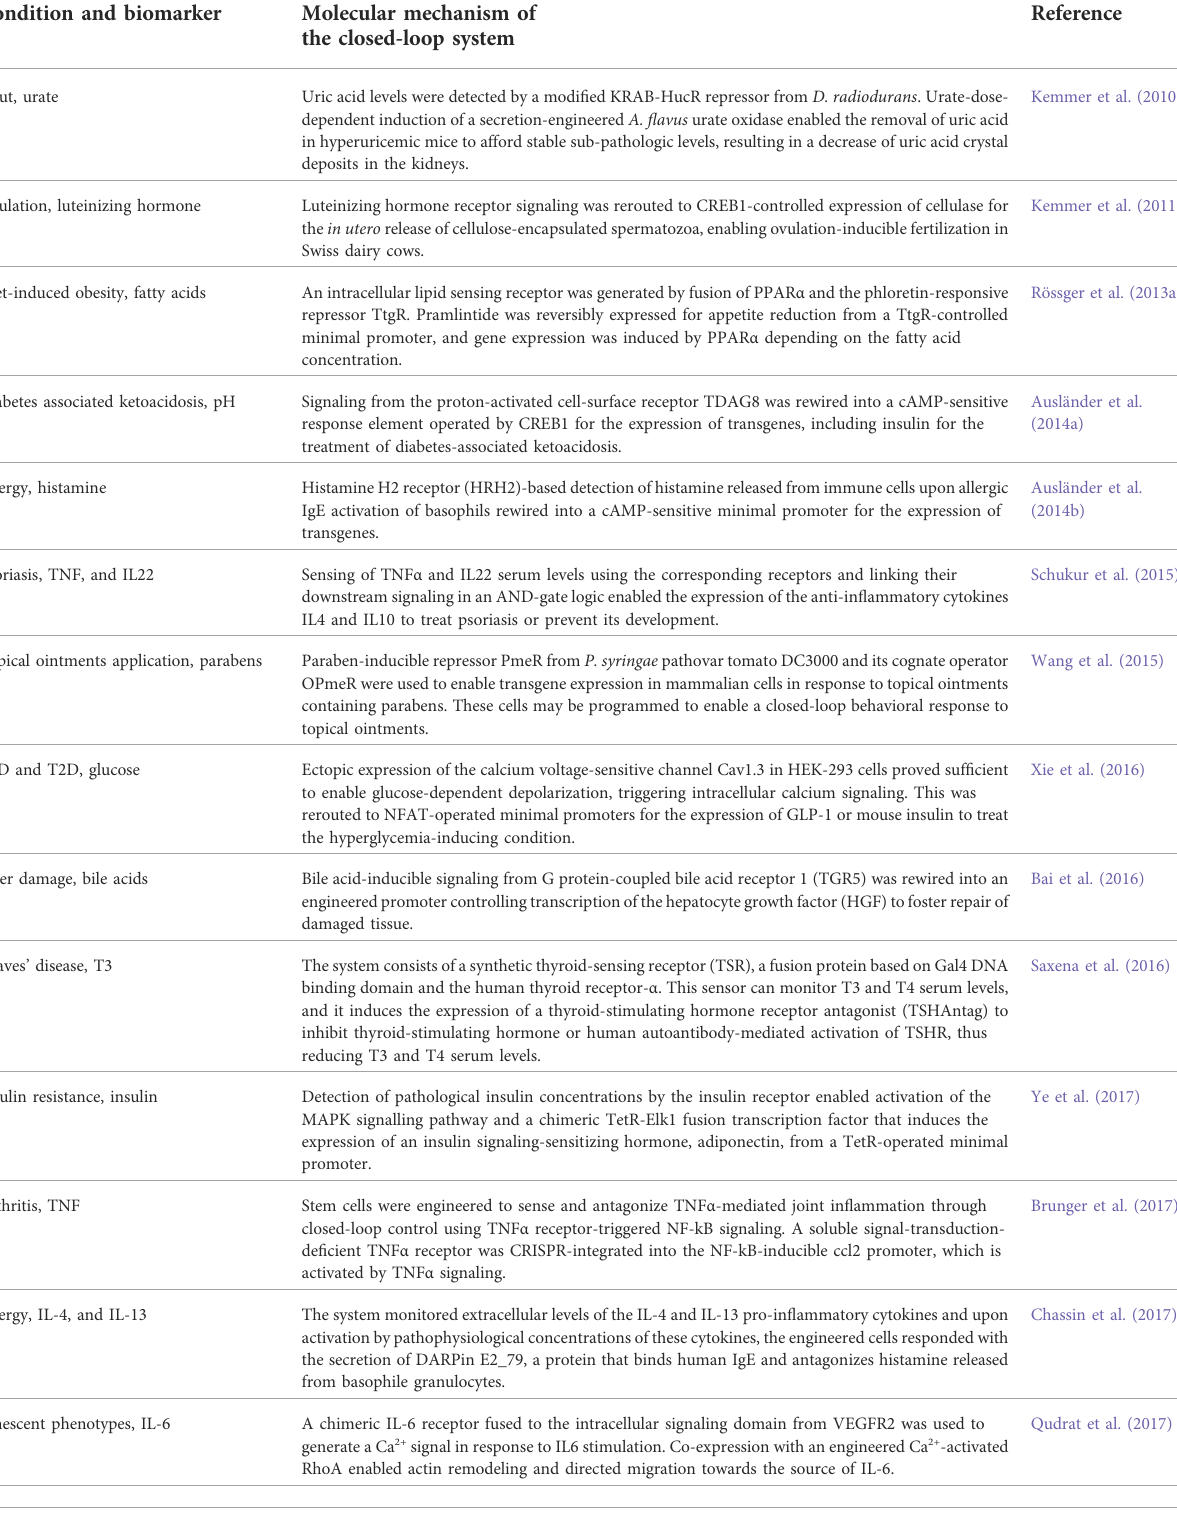
TABLE 1 Overview of closed-loop-compatible cell therapies with potential for translation to treat complex